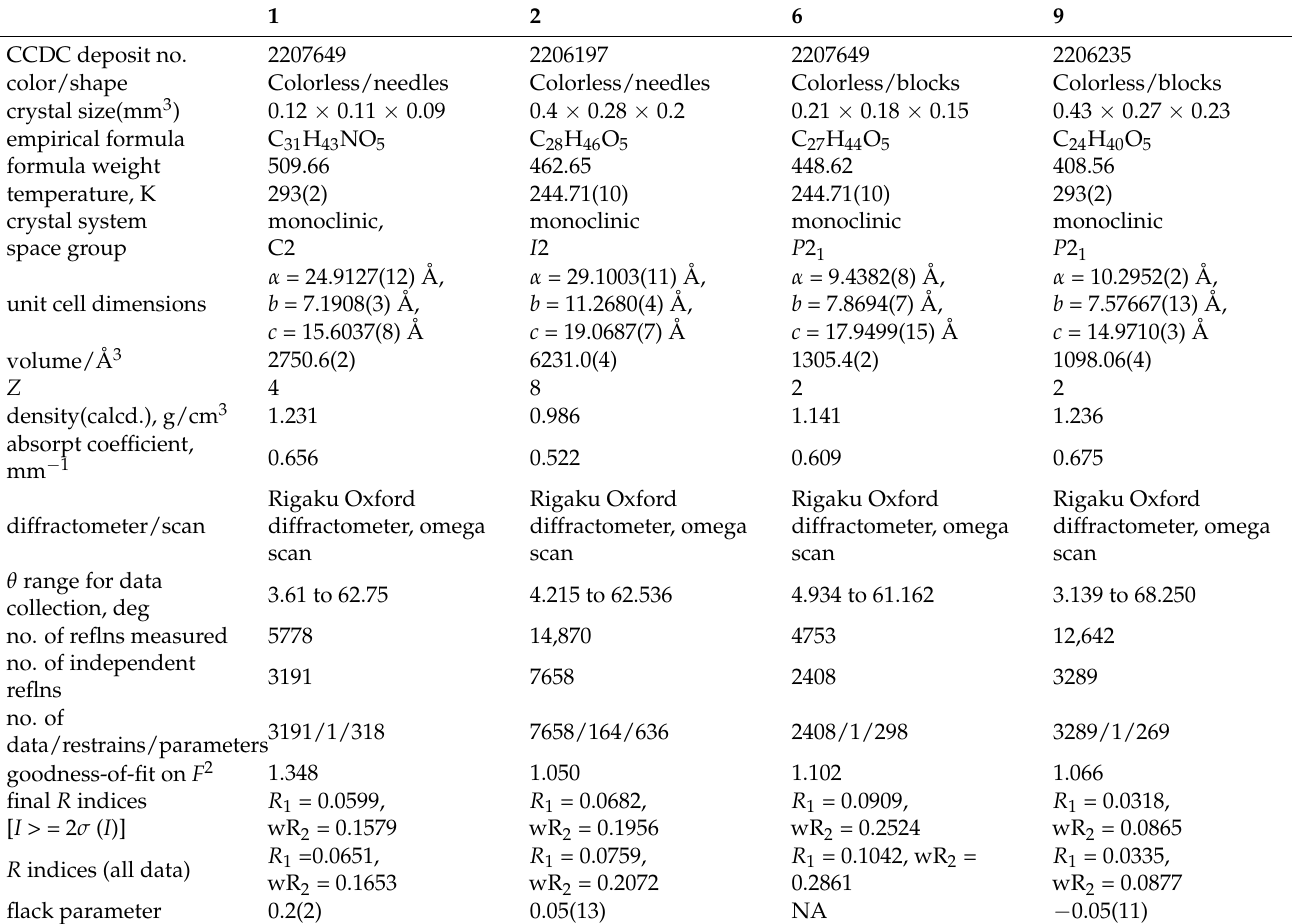
Table 3. Crystallographic data of compounds 1 , 2 , 6 , and 9